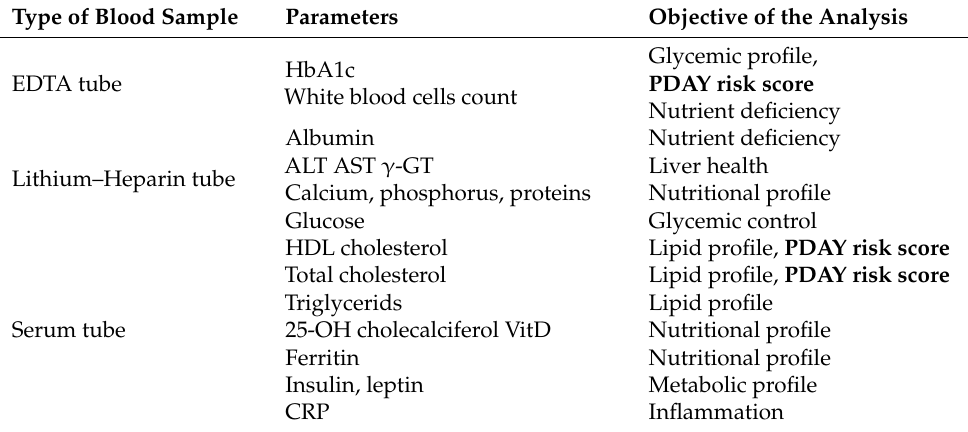
Table 2. Blood sampling process and parameters analyzed in the BELINDA study.